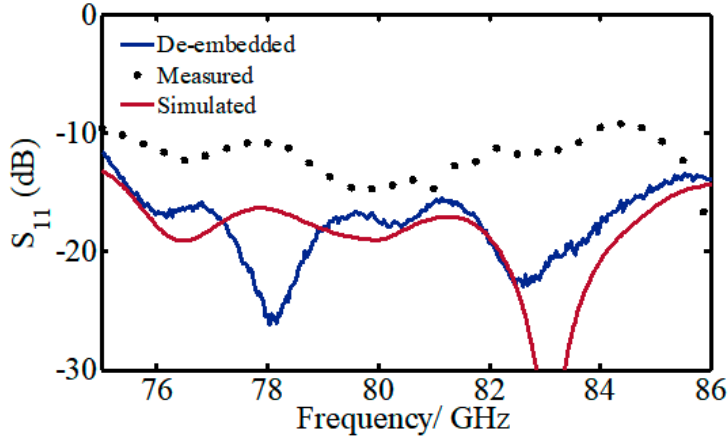
Figure 7. Magnitude of the reflection coefficient for the two-row prototype adapted for probe measurements. The black dots represent the measurement taken directly from the VNA, whereas the blue curve represents the measurement after de-embedding the probe and the interconnection.